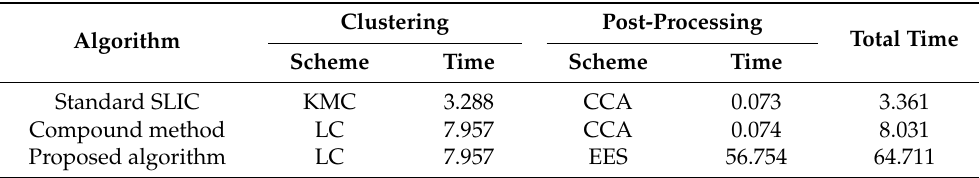
Table 1. Time (in seconds) of the three superpixel algorithms for 0.6 w  on the simulated synthetic aperture radar (SAR) images.